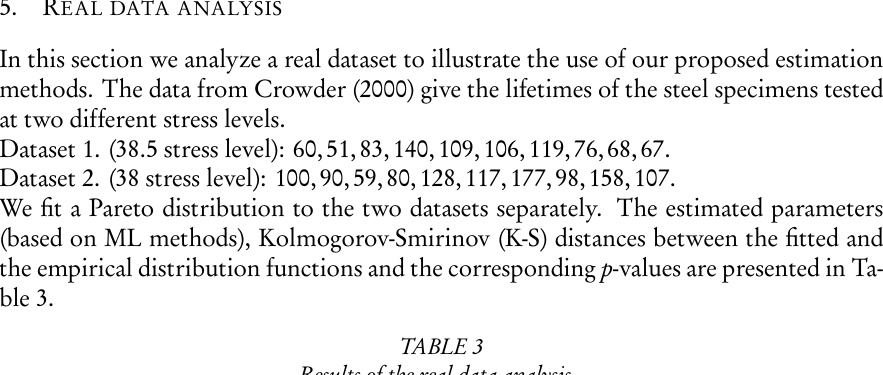
Results of the real data